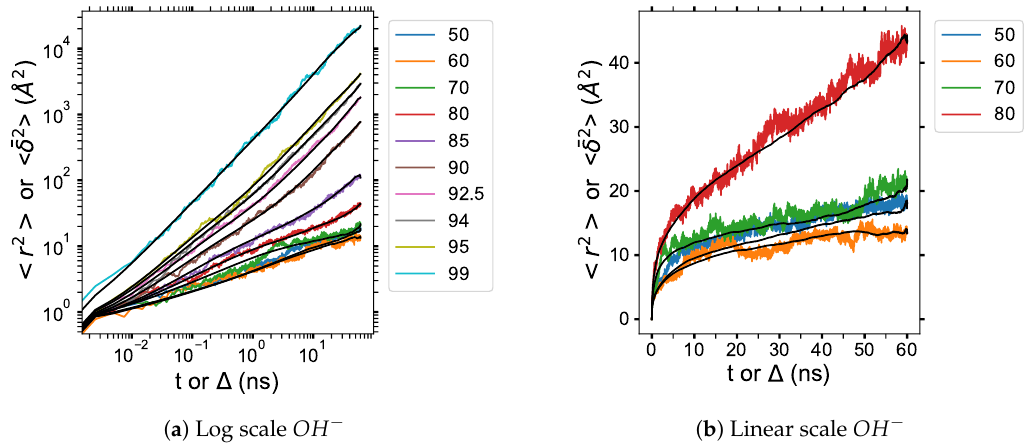
Figure 19. Mean squared displacement (MSD) vs. particle-averaged TAMSD of the OH ion in TBPH–water at p = 1atm and T = 300K as a function of water concentration: ( a ) MSD and particle-averaged TAMSD of OH − plotted on a log scale; ( b ) MSD and particle-averaged TAMSD of OH − plotted on a linear scale. The colored lines are the MSDs, and the black lines are the particle-averaged